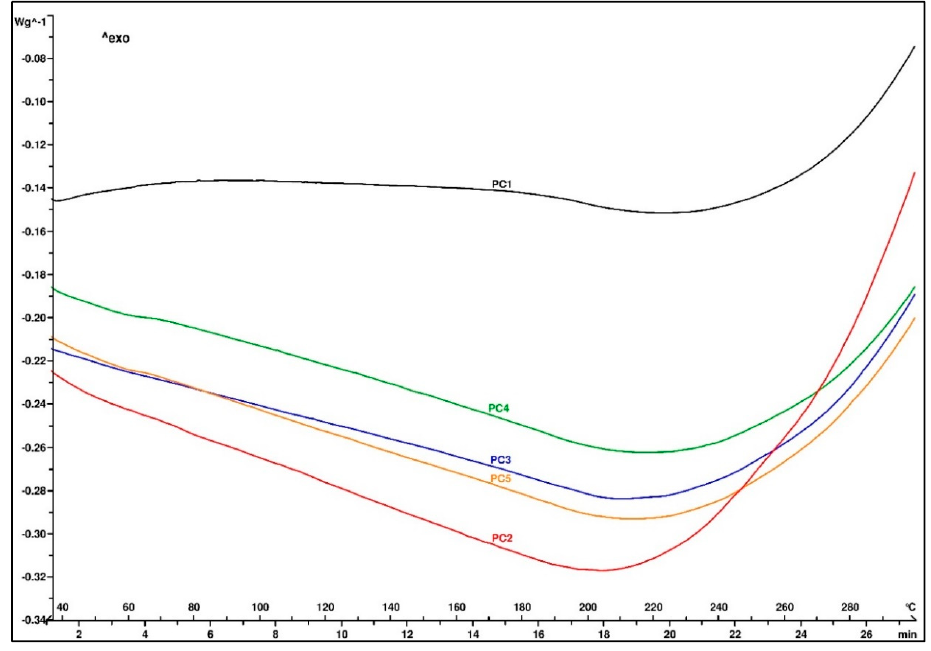
Figure 5. DSC determination of decomposition temperature.